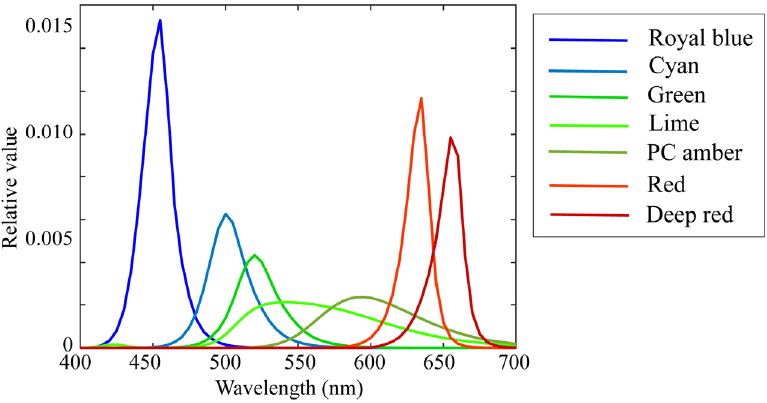
Figure 5. Spectral power distributions of seven LED light sources used in current experiments.